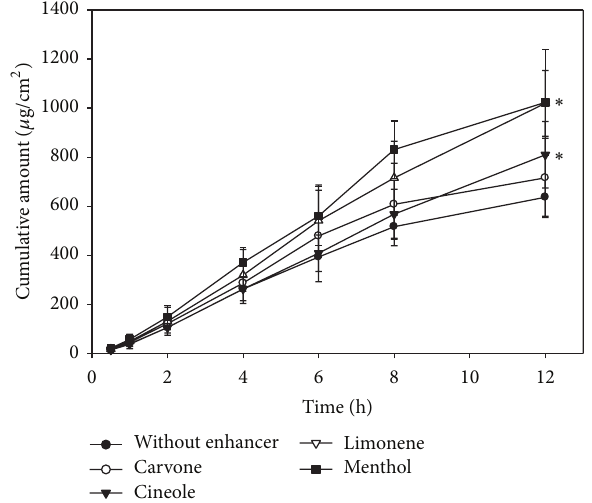
Figure4: In vitro penetration-timeprofileofarecoline-loadedpatch with 5% terpenes as enhancers through rat skin ( 𝑛 = 3 ) ( ∗ significant difference 𝑃 < 0.05